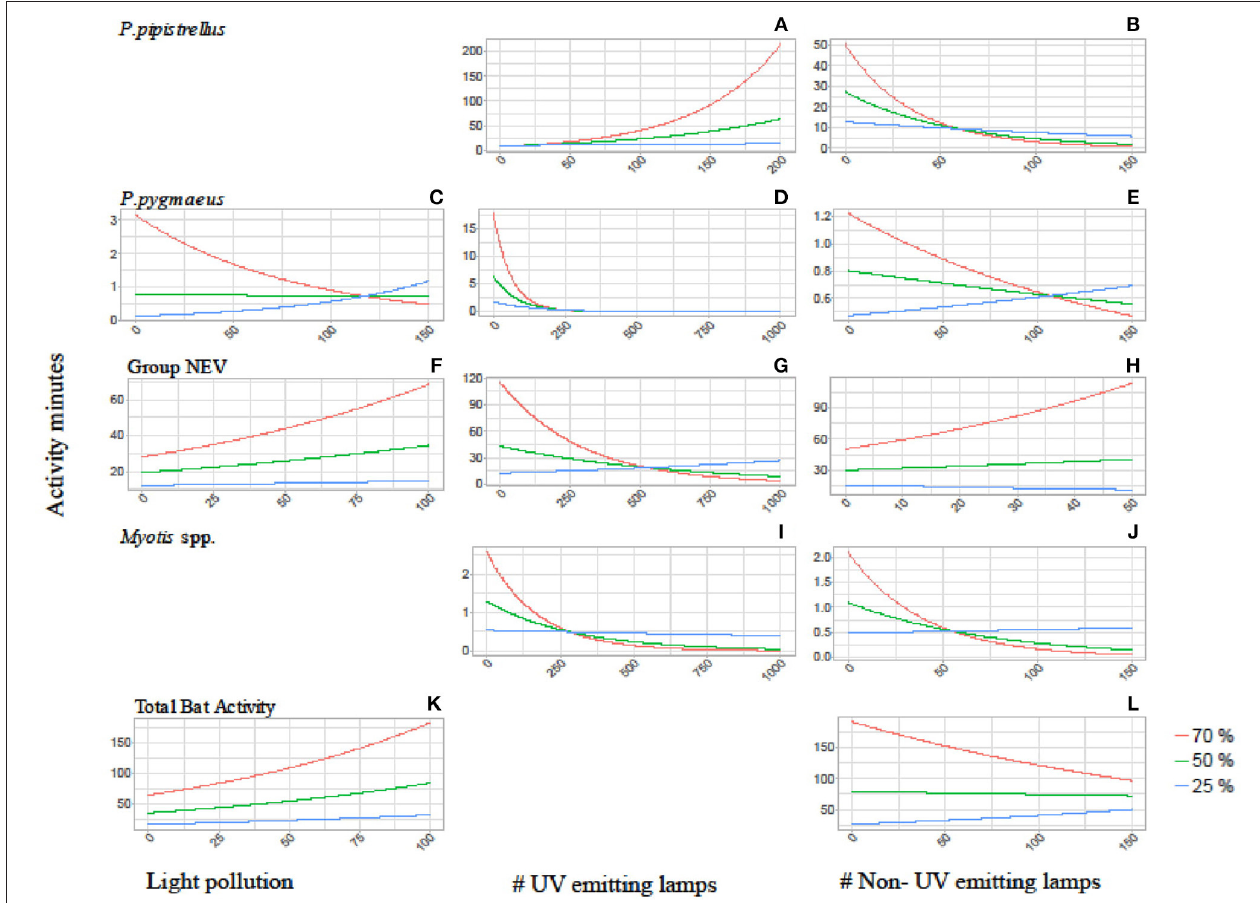
FIGURE 2 | Interaction plots showing the activity of P. pipistrellus (A,B) , P. pygmaeus (C–E) , Group NEV (F–H) , Myotis spp. (I,J) and total bat activity (K,L) in relation to the three tree cover densities (red = 70%, green = 50%, blue = 25%) and the three light variables: overall light pollution (left side graphs), number of UV emitting street lamps (mid graphs) and number of non-UV emitting street lamps (right side graphs). Blank sections indicate that the interaction between tree and light variables were not found to be relevant for the final model (see Appendices 1 , 2